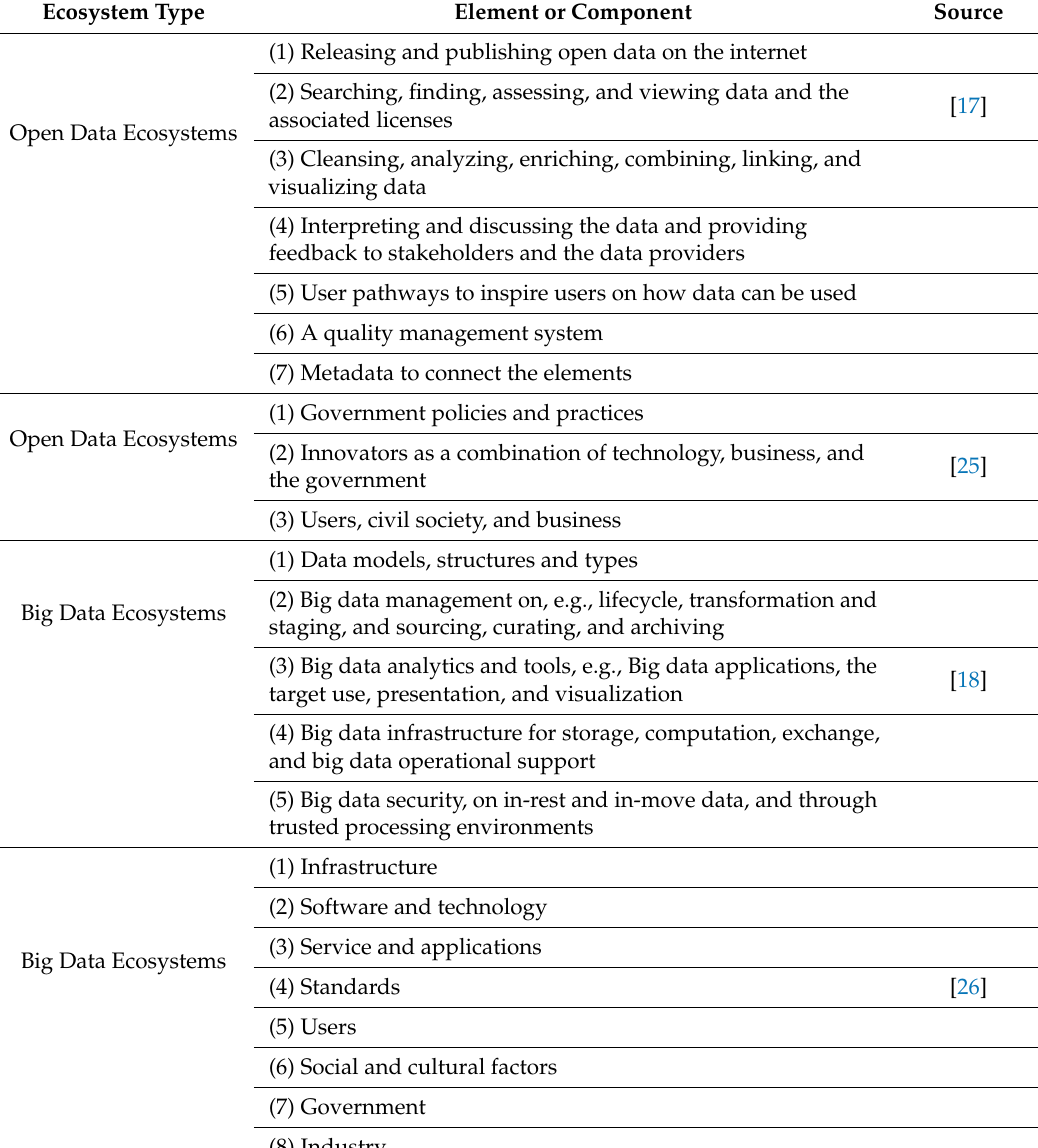
Table 1. Overview of data ecosystem elements and